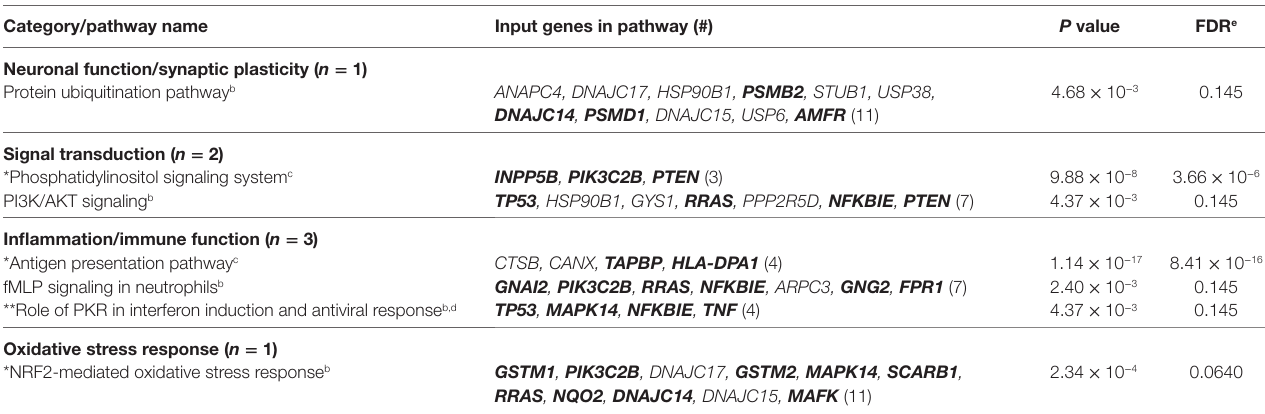
TaBle 4 | Significantly enriched pathways for 300 genes consistently detected exclusively in weeks 8 and 12 topiramate (TPM) groups based on secondary outcomes ( n = 7).